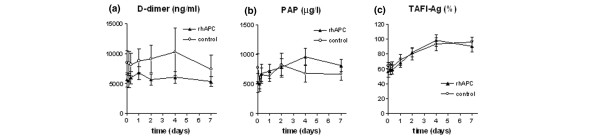
Fibrinolysis. Plasma levels of (a) D-dimer, (b) PAP and (c)TAFI-Ag in the rhAPC group (▴) and the control group (○). TAFI levels are expressed as the percentage of the level measured in normal pool plasma. Data represent mean ± SD. PAP, plasmin-antiplasmin complexes; TAFI-Ag, thrombin-activatable fibrinolysis inhibitor antigen; rhAPC, recombinant human activated protein C.